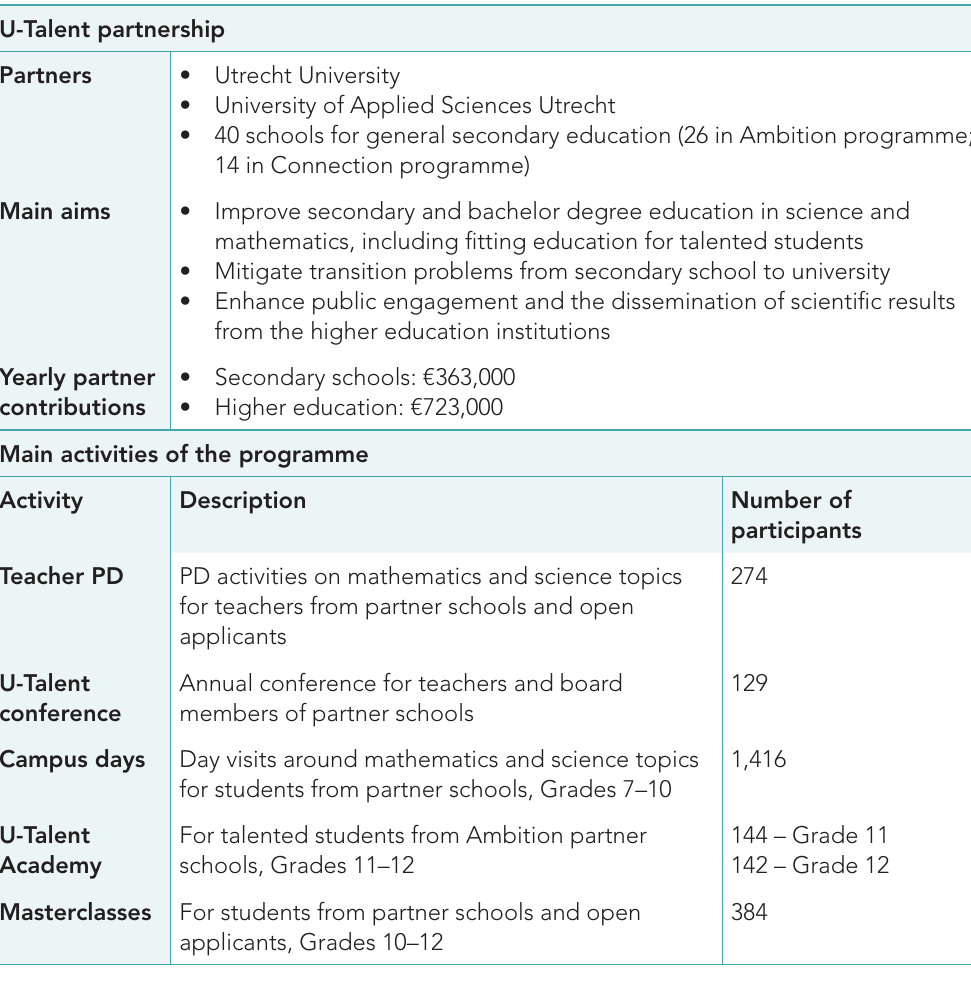
Table 1: An overview of the U-Talent partnership and programme (data for